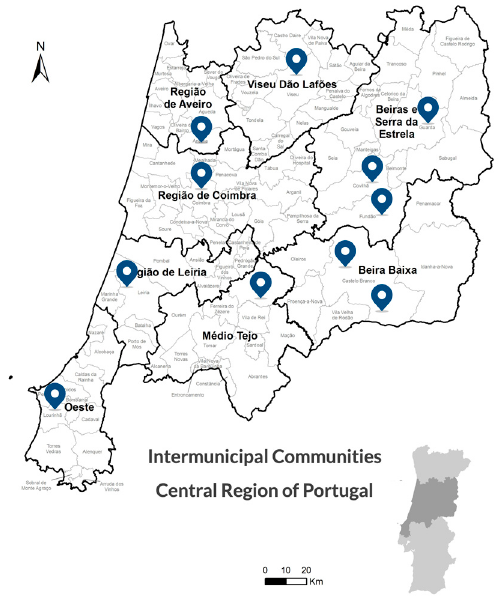
Figure 1. Subregions where representatives of both the media and the public come from.